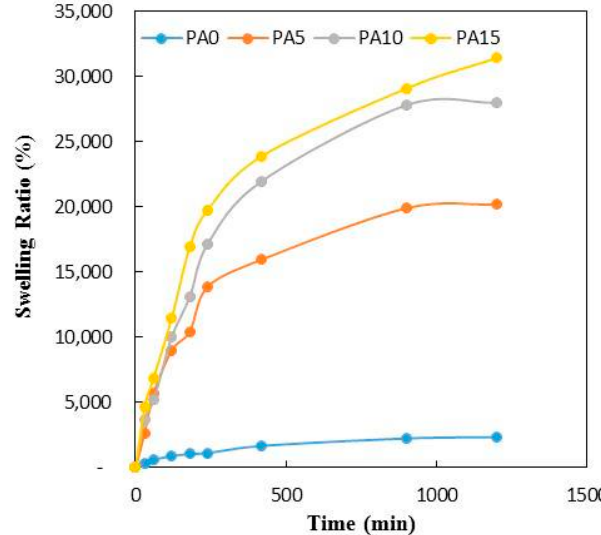
Figure 7. Swelling ratio of PA hydrogels with various concentrations of AAc as a function of time at radiation dose 30 kGy.